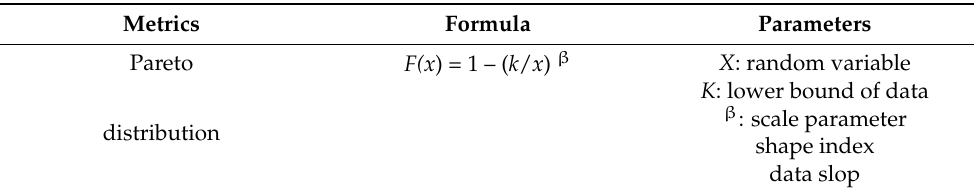
Figure 5. Gaussian and Pareto Approaches Contrary to the Gaussian approach, the Paretian approach’s standpoint offers differ- ent strategic plans that focus on tails, where minimum levels exist between variables [20 − 21]. Decentralising the nature of end-user demand in an electrical smart grid system is complex and related to the Paretian approach. We focus on visualising the perceived internal and external locus of causality in electrical grid systems and define whether con- trollable or uncontrollable end-users provide the solutions to electricity issues and failure. Apart from this, we plotted the main technical and social factors that influence electricity losses in the grid system and found that as population (number of people and grid system components) increases, grid performance decreases due to electricity losses. Paretian distribution in Figure 3 illustrates optimum performance where electricity generation is located (X-axis) due to negligible losses based on small human and technical